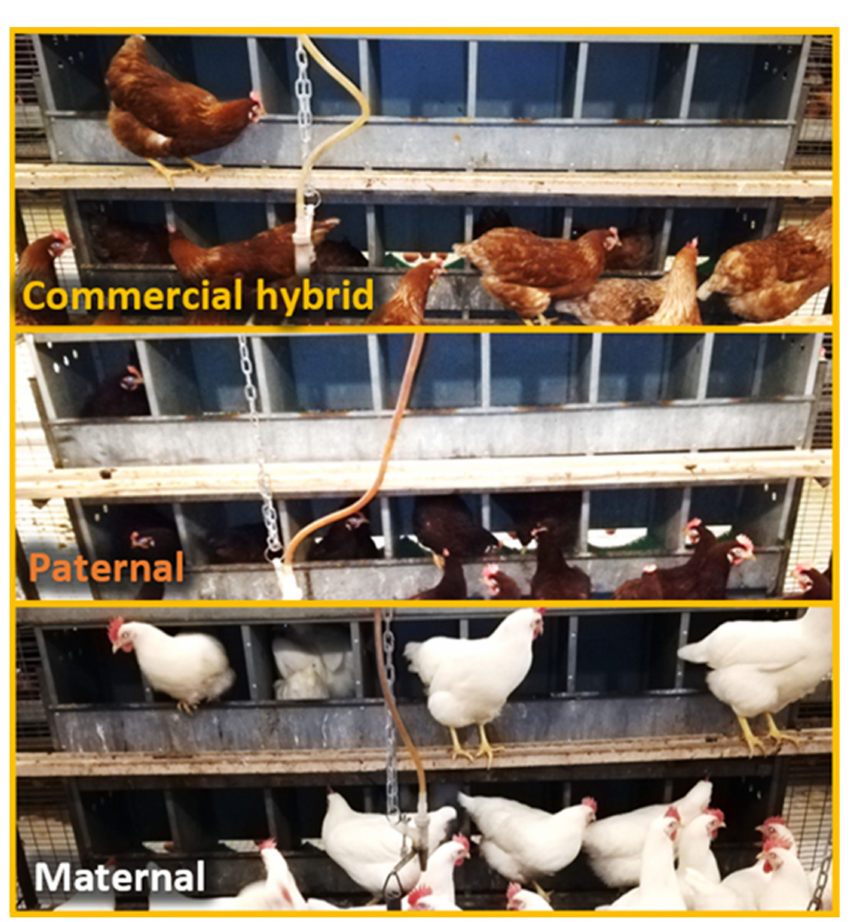
Figure 1. The experimental flocks with the three different genetic backgrounds (commercial hybrid ( above ) and the purebred offspring of the paternal (in the middle ) and maternal lines ( below )). The set numbers were: N = 318; n = 106 hens/genotype; 53 hens/pen, i.e.,